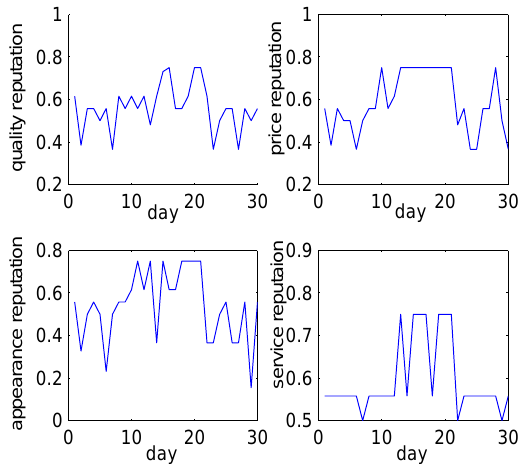
Fig. 5. Each Item Index Reputation Vague Value